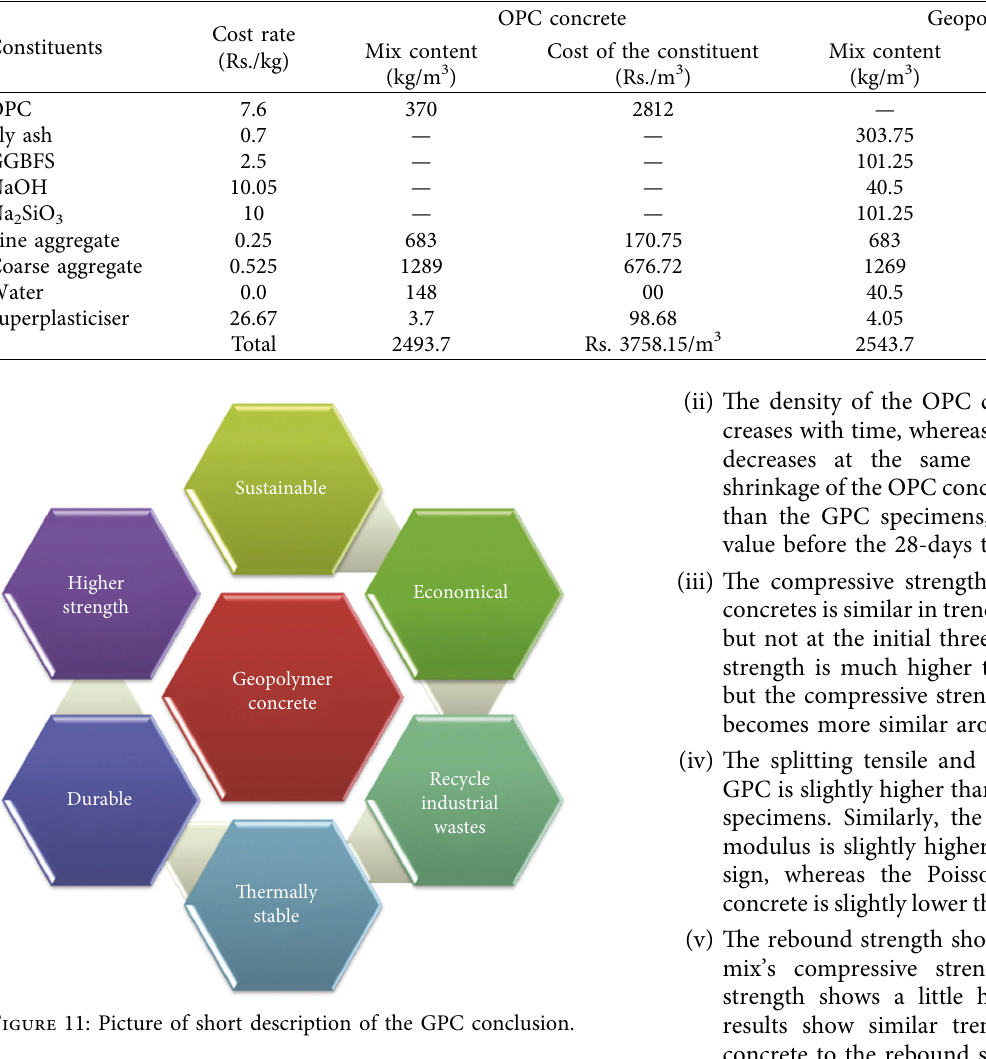
Table 4: Cost analysis of the GPC and OPC concrete.